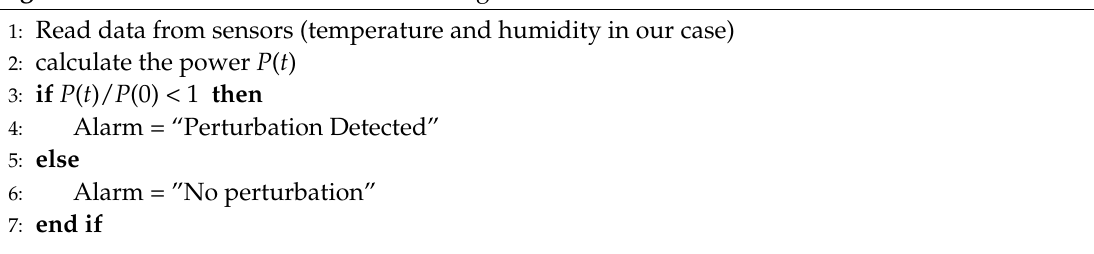
Algorithm 5 Pseudo code of ESA Monitoring behaviour